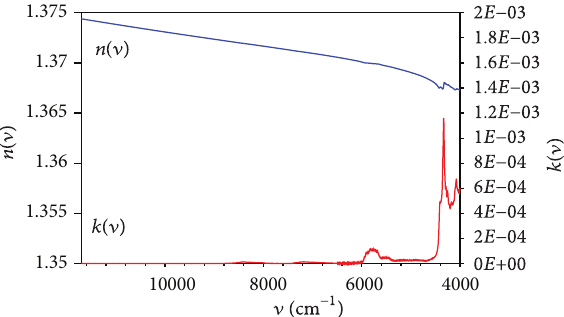
F 1: Spectrum of the complex refractive index of NBEE in the NIR range (11700–4000cm −1